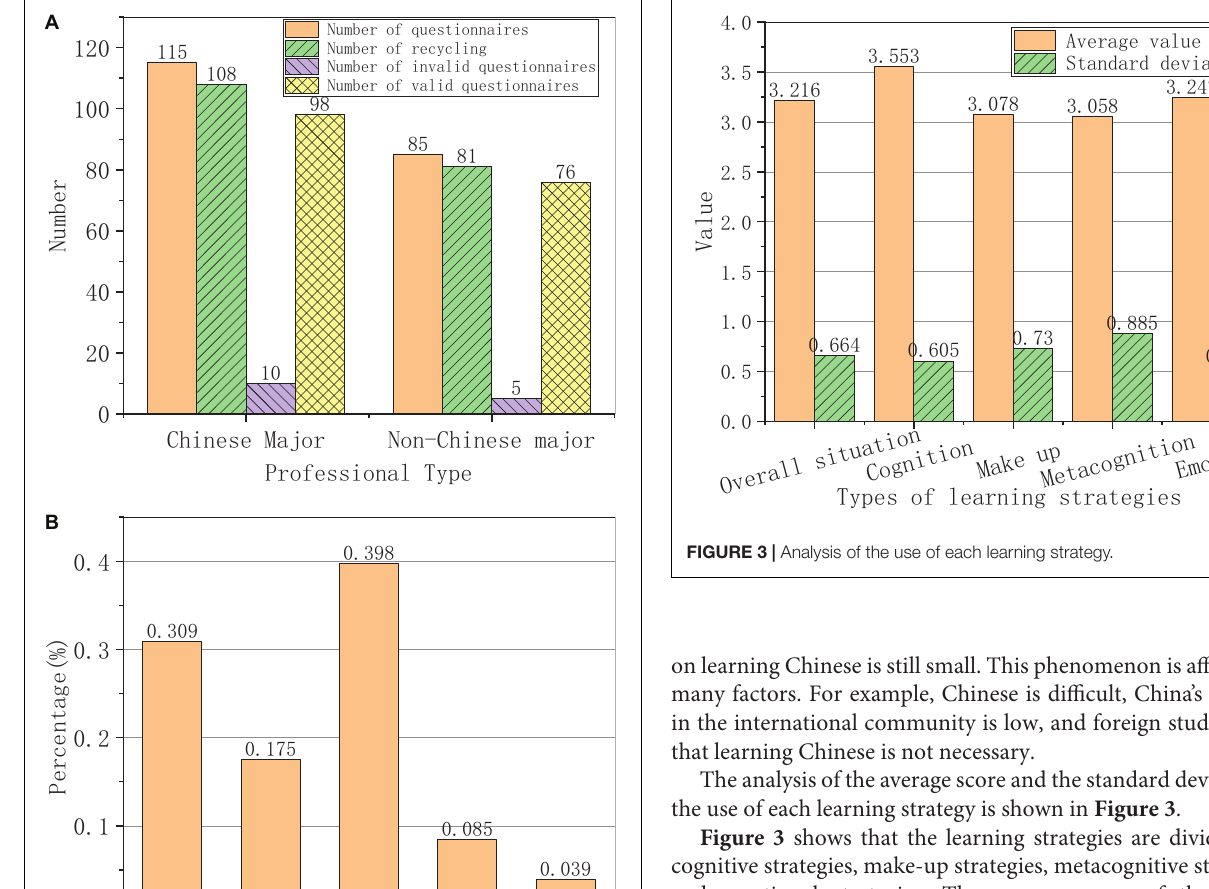
The major distribution of the questionnaire is shown in Figure 2A . The distribution of foreign students’ Chinese learning is shown in Figure 2B .